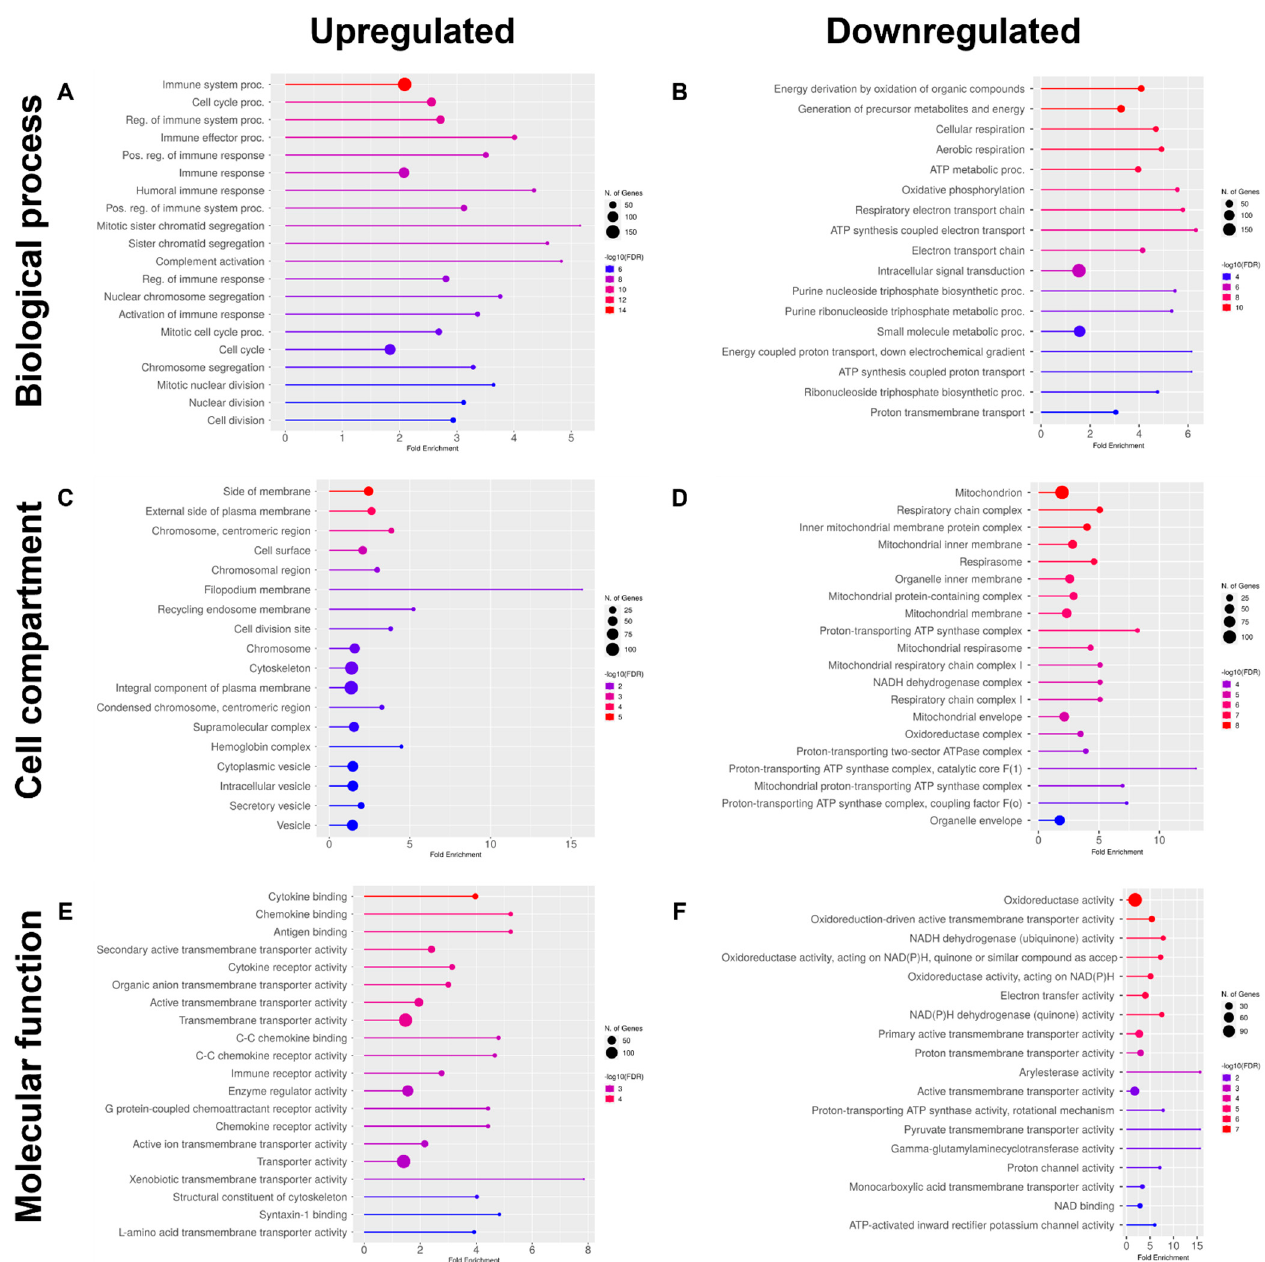
Figure 2. Gene ontology (GO) enrichment analysis of pathways upregulated and downregulated in renal tissues from the mutant, compared to wildtype ZF. Data refers to GO Biological Process (BP: ( A ) and ( B ), respectively), Cellular component (CC, ( C ) and ( D ), respectively) and Molecular function (MF: ( E ) and ( F ), respectively). In all cases, the twenty most enriched pathways are reported. FDR ≤ 0.05.